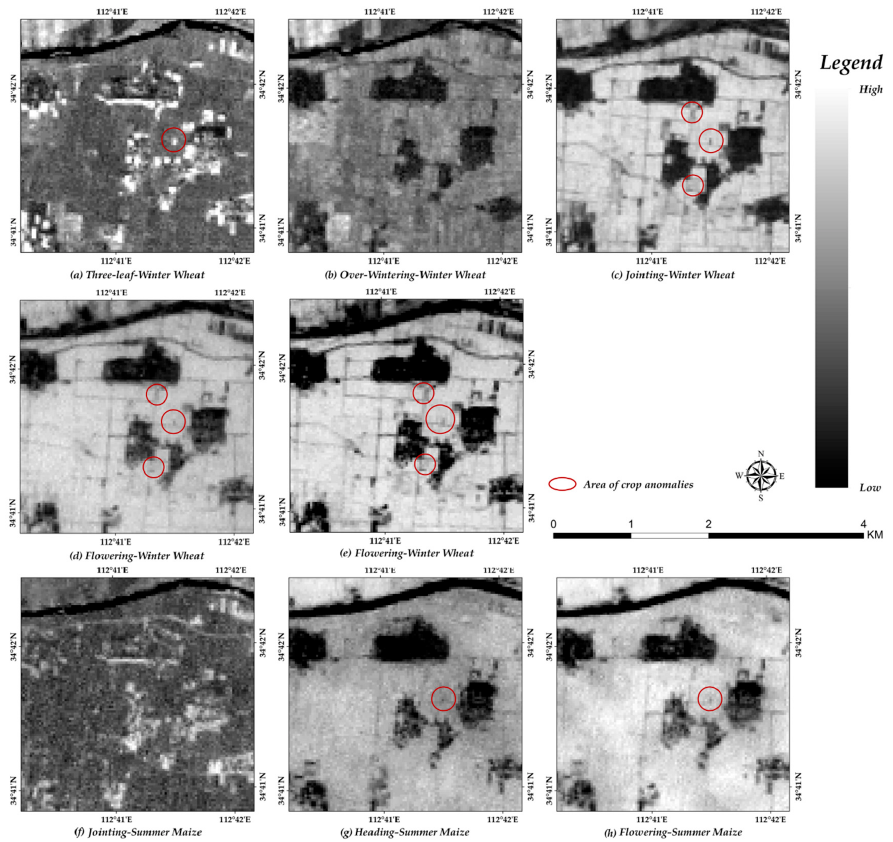
Figure 6. Landsat NDVI time series images from 1999–2000 of Erlitou. Winter wheat: ( a ) Three-leaf (12 November 1999); ( b ) Over-wintering (7 December 1999); ( c ) Jointing (28 March 2000); ( d ) Flowering (28 April 2000); ( e ) Flowering (6 May 2000). Summer maize: ( f ) Jointing (16 June 2000); ( g )